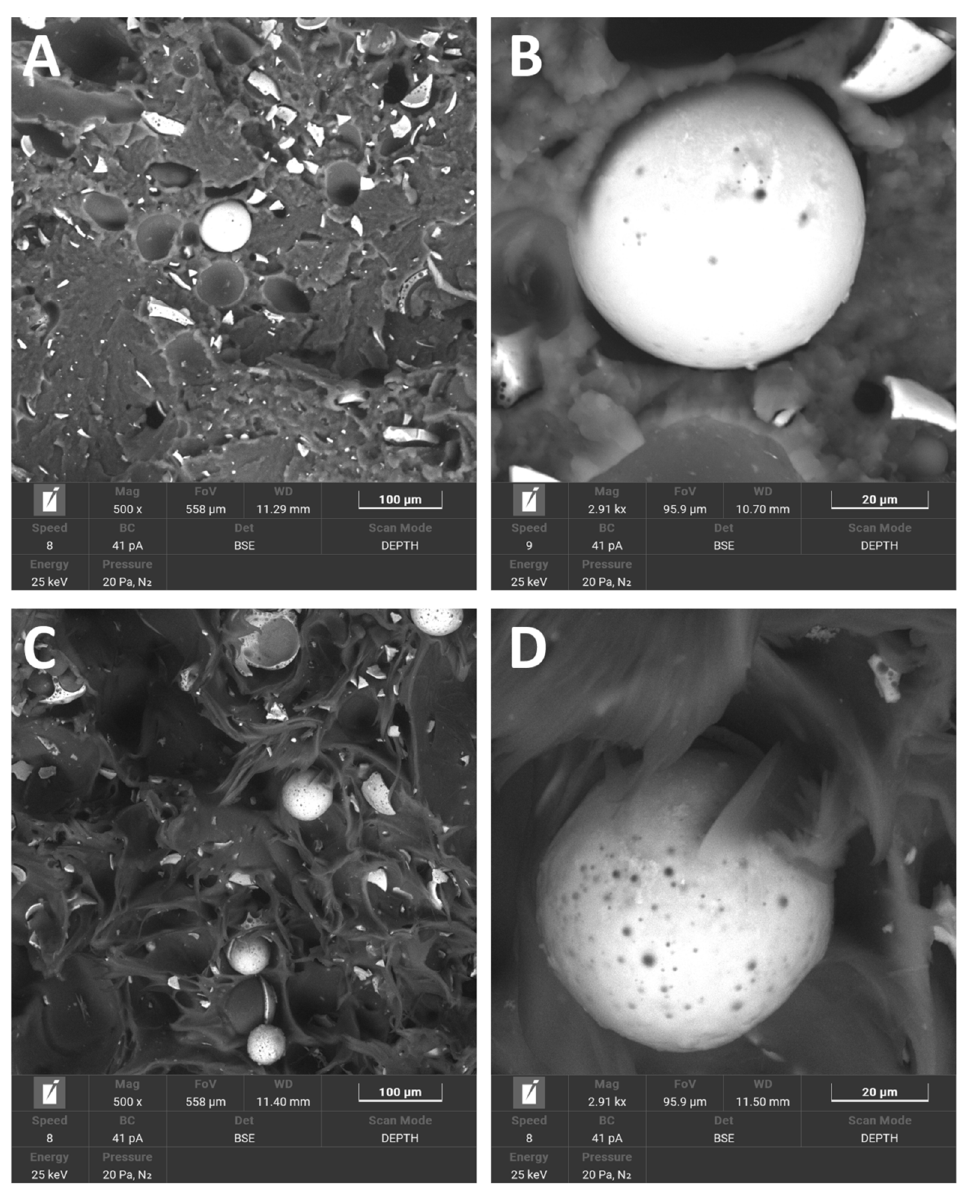
Figure 15. SEM microphotographs of breakthrough PA-12_CS samples: ( A ) CSs without a surface modification, ( B ) detail: surface of unmodified CSs, ( C ) CSs with surface modification, ( D ) detail: surface-modified CSs.